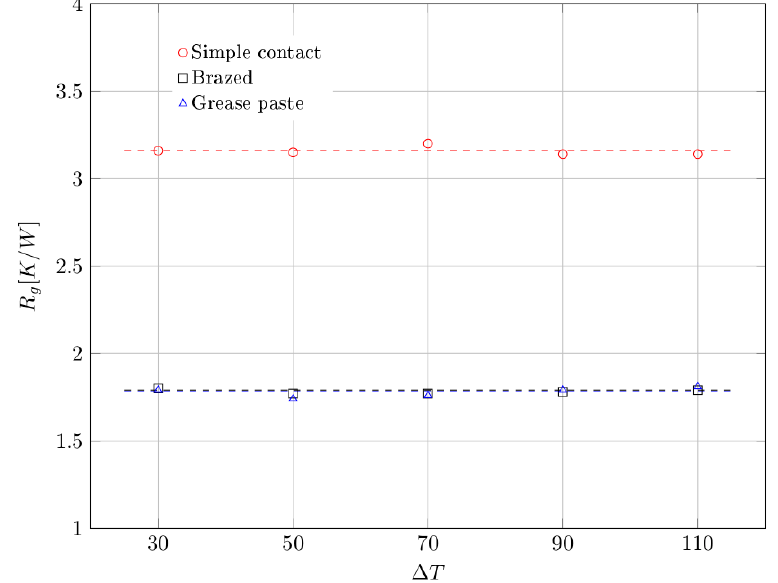
Figure 10. Global thermal resistance as a function of differential temperature, for each type of contact. Dashed lines represent the average values.